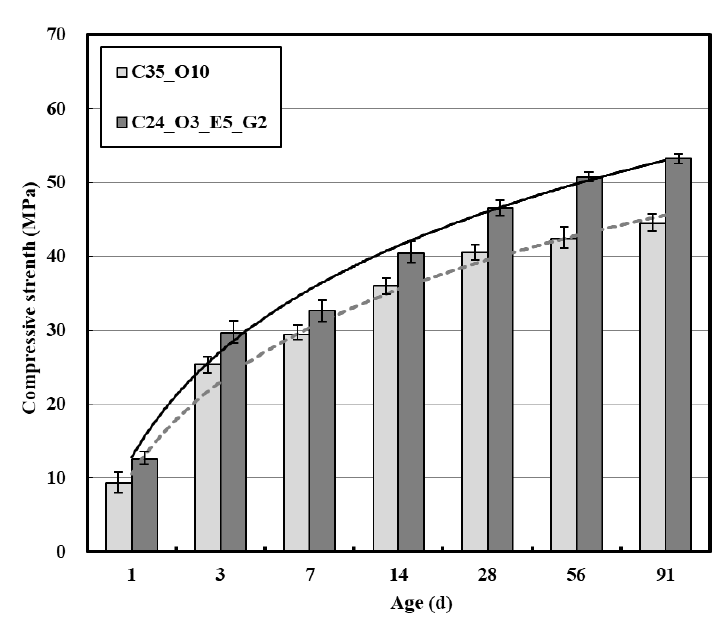
Figure 6. Compressive strength of concrete with age.